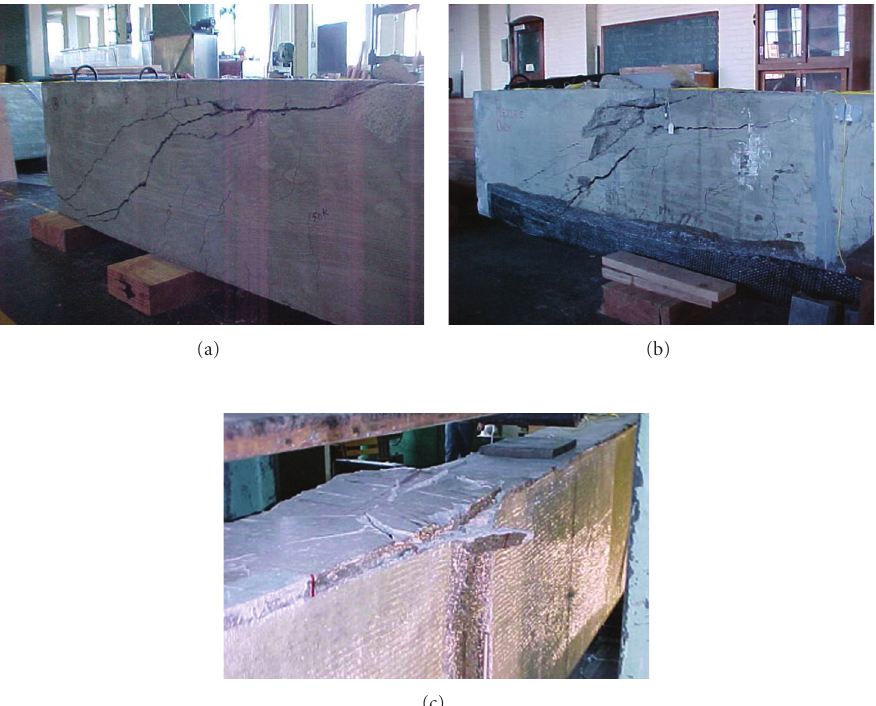
Figure 8: Experimental beams at failure. (a) Unstrengthened beam; (b) flexural-strengthened beam; (c) shear-strengthened beam.